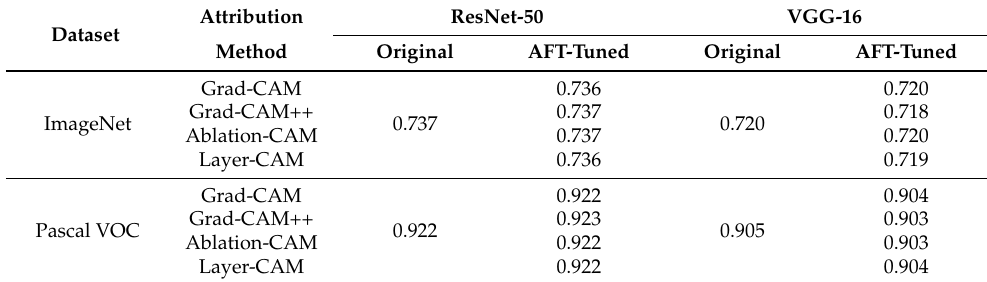
Table 4. Comparison of test set prediction accuracy rates of the original and the AFT-tuned